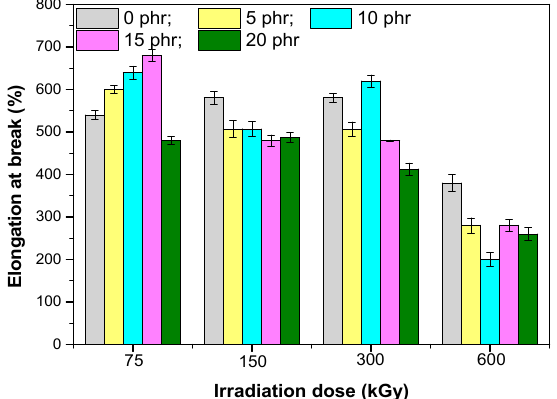
Figure 3. Elongation at break versus EB irradiation dose and the amount of hemp fibers.